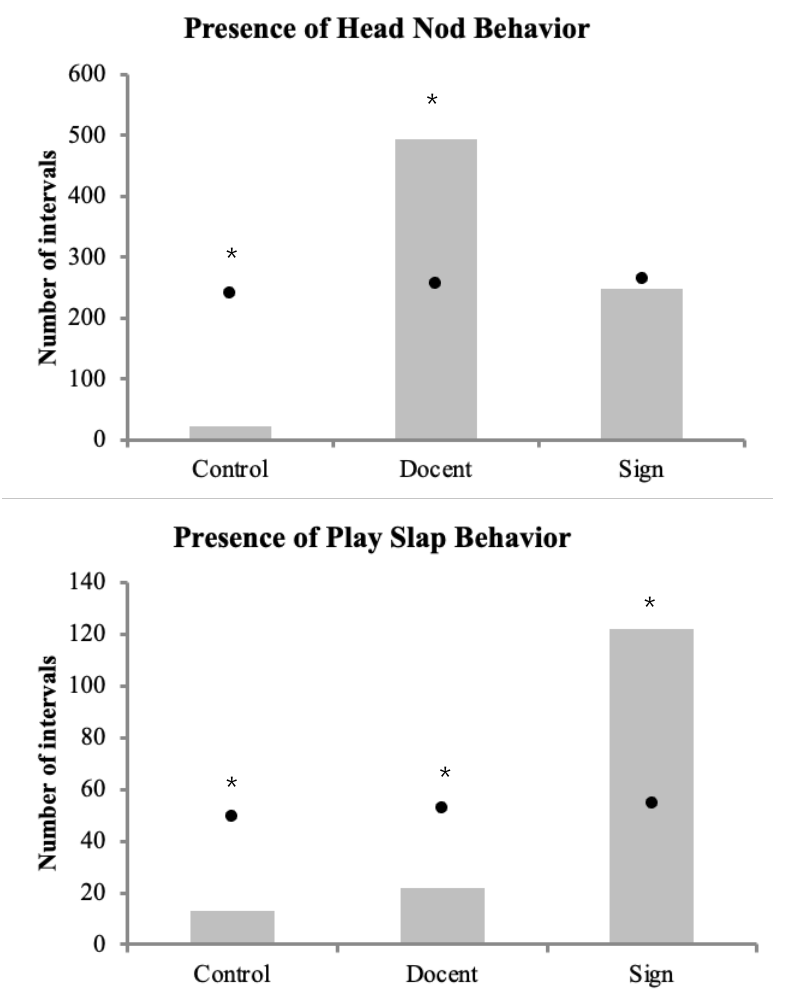
Presence of Head Nod and Play Slap